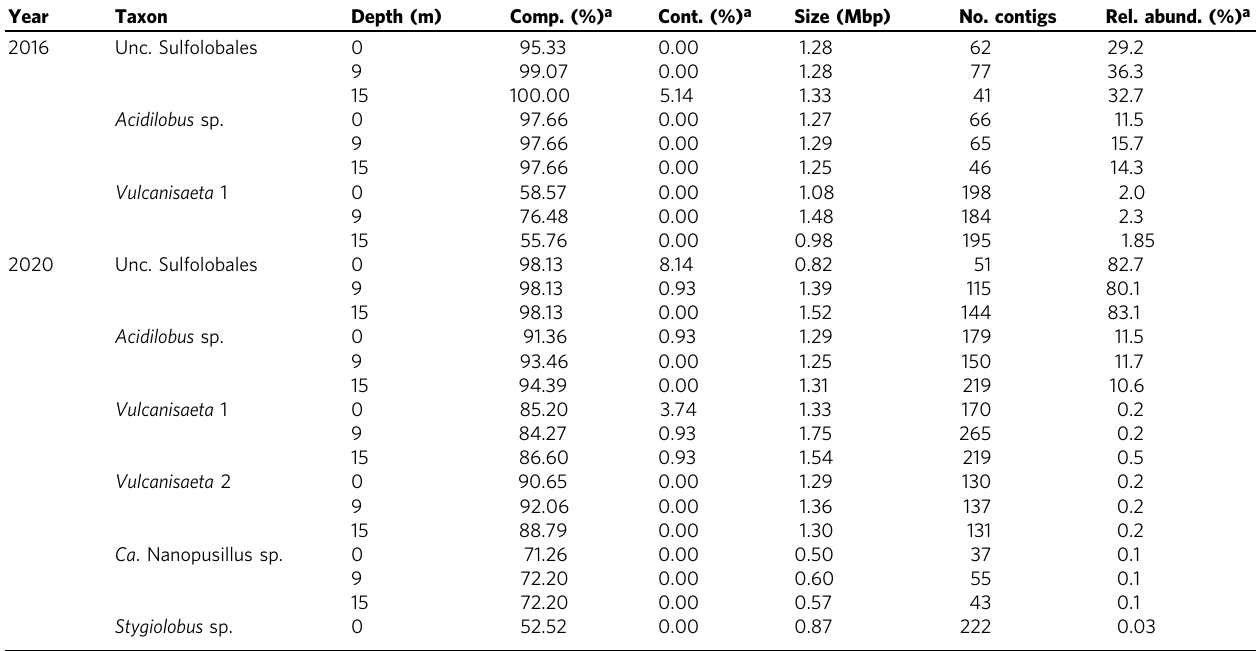
Table 1 Cinder Pool archaeal population and genome information.